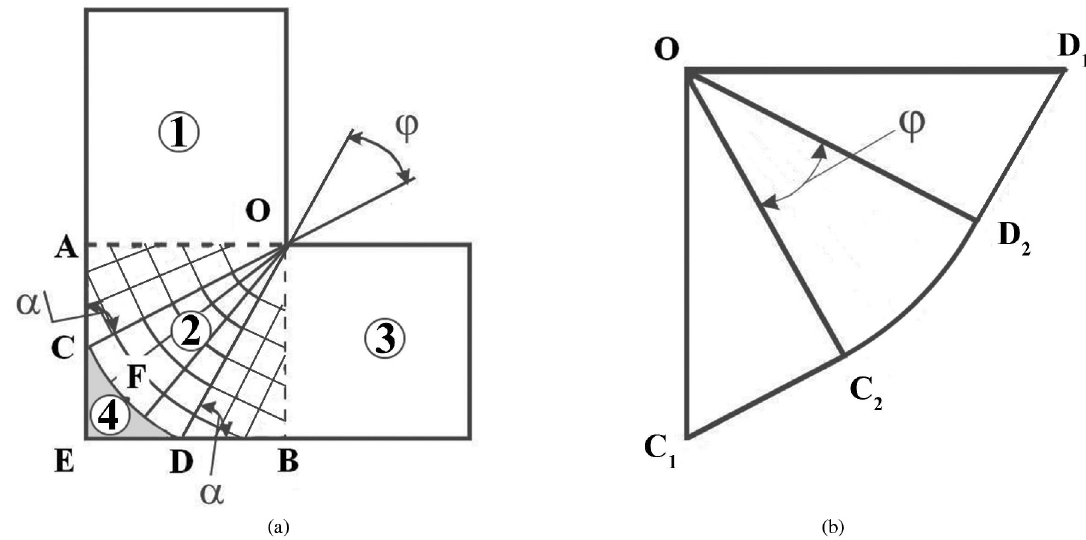
Figure 5. Slip line field (a) and corresponding hodograph (b) used for ECAE